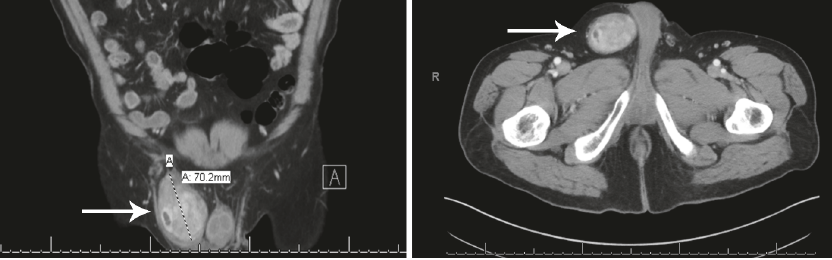
Figure 1: Computed tomography (CT) scans revealing a partially visualized, heterogenous enhancing right inguinal mass (arrows).